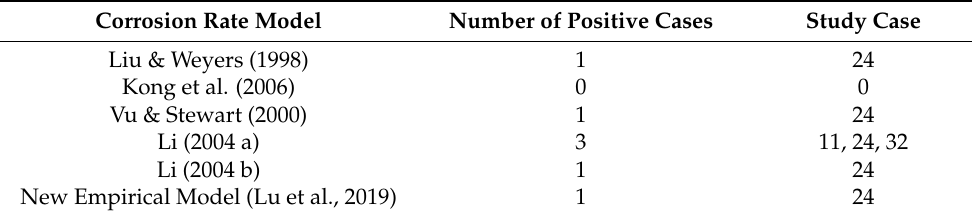
Table 10. Corrosion rate models and number of cases of prestressed and post-tensioned concrete structures with favourable